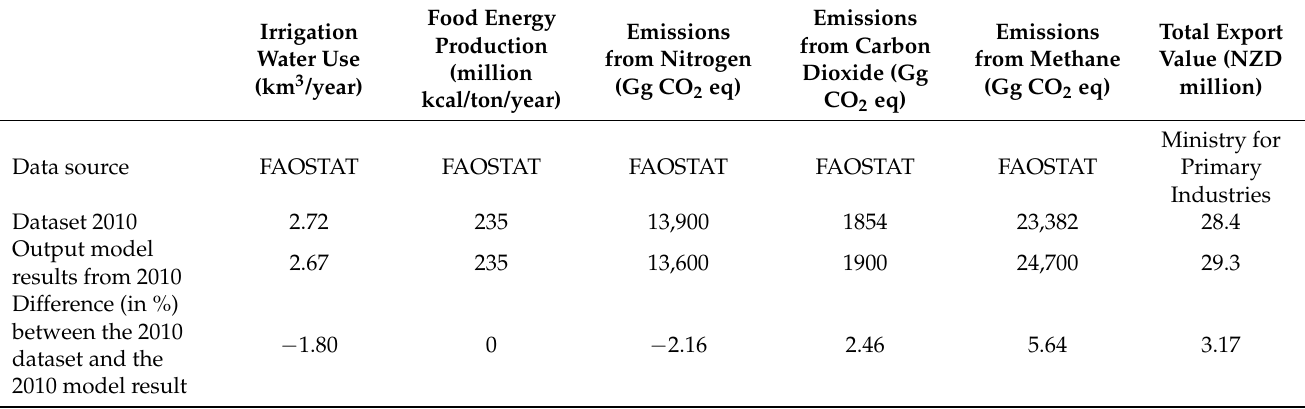
Table 5. Validation results using the 2010